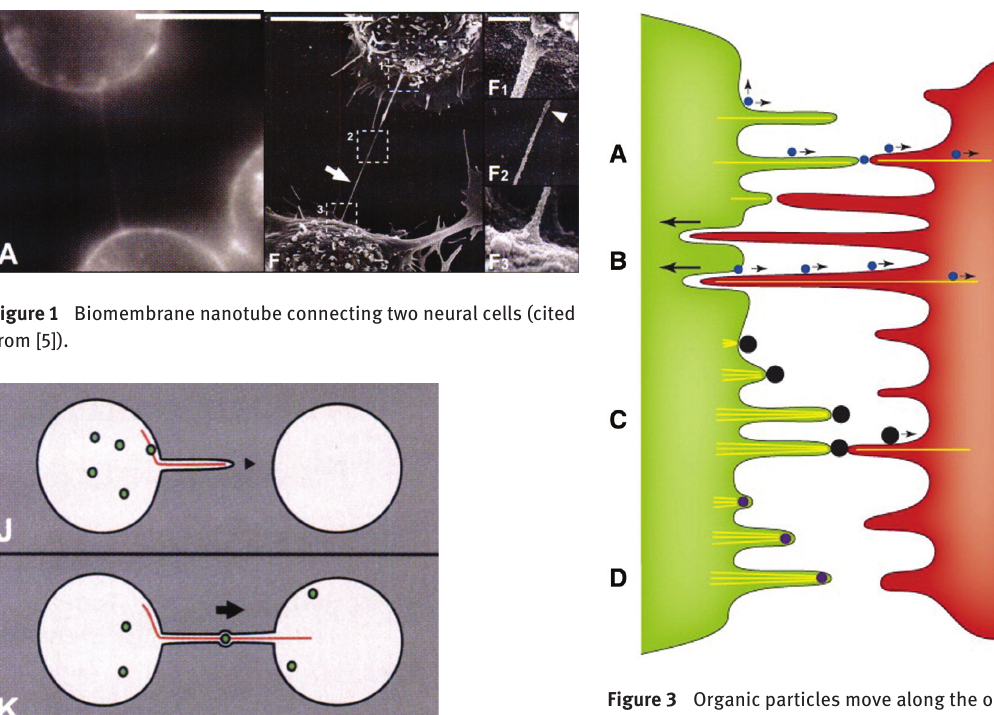
Figure 3 Organic particles move along the outer surface of biomembrane nanotubes (cited from [6]).